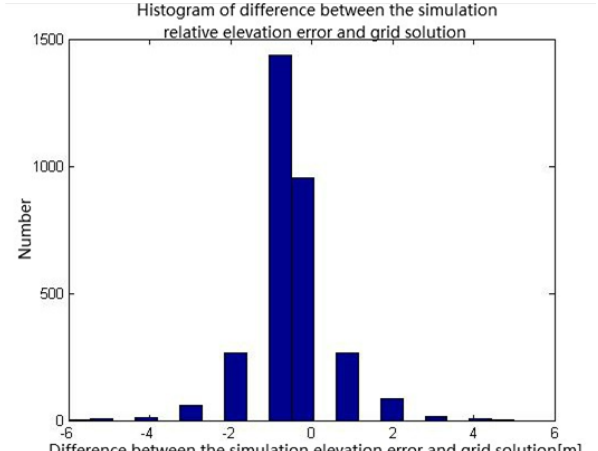
Figure 5 Histogram of difference between the simulation elevation error and grid search